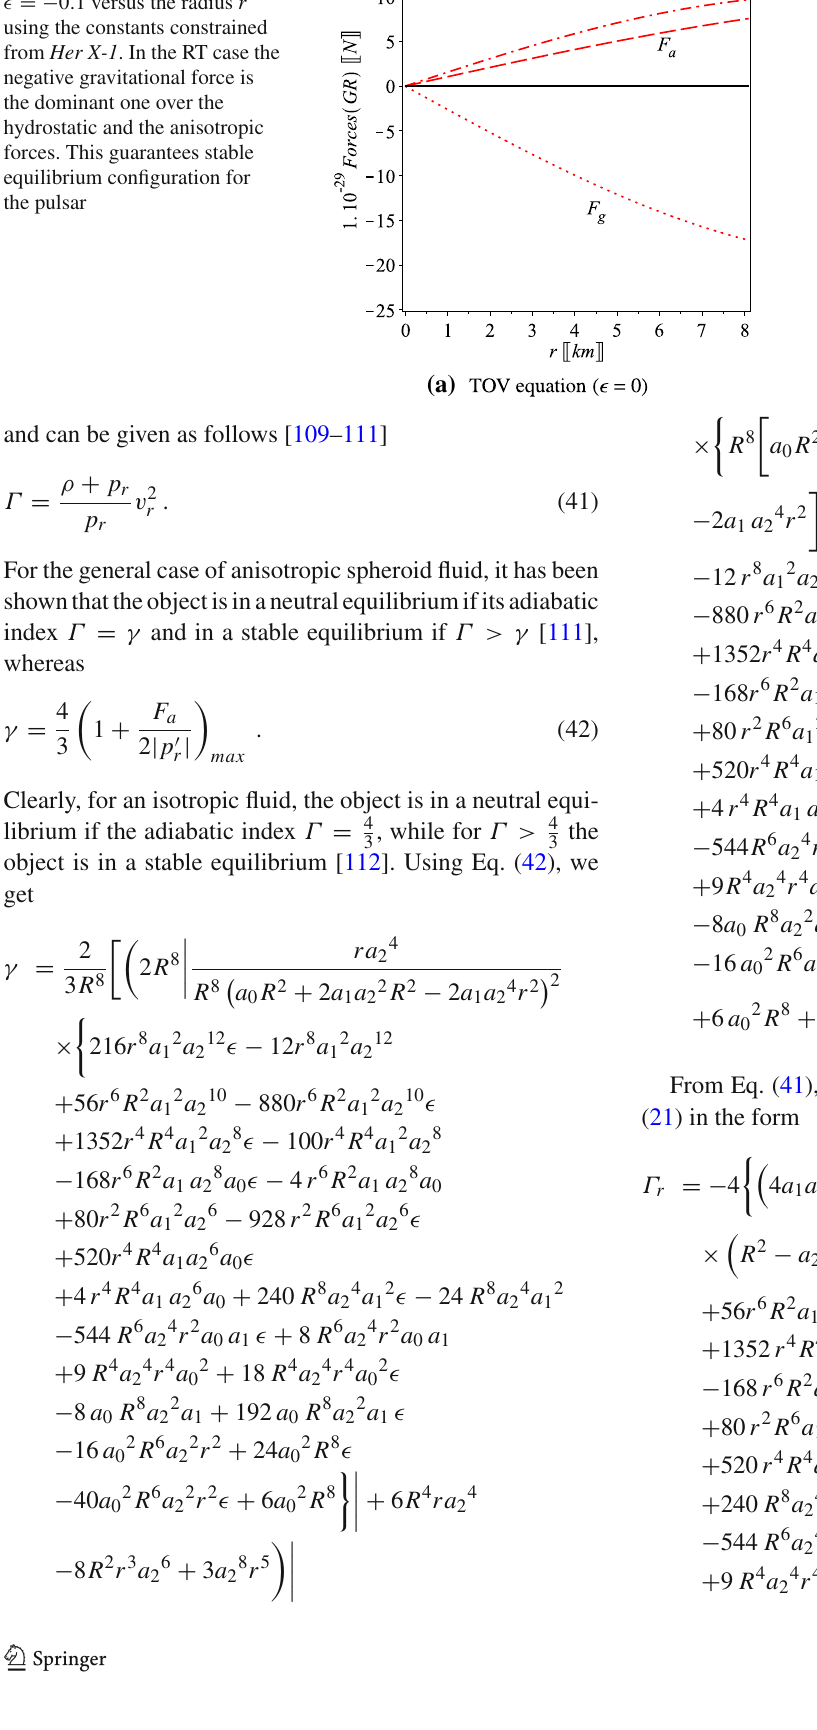
Fig. 7 Plots of the forces of TOV Eq. (39) in cases (cid:2) = 0 and (cid:2) = − 0 . 1 versus the radius r using the constants constrained from Her X-1 . In the RT case